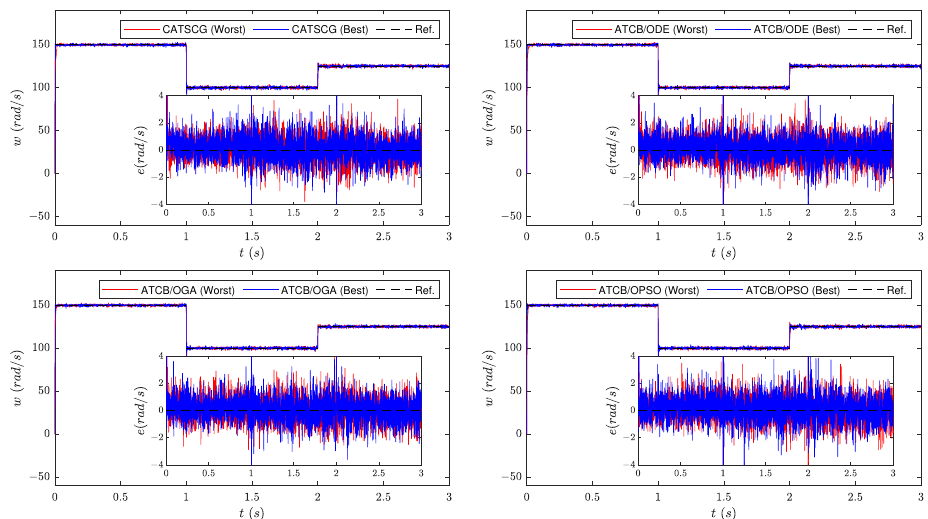
Figure 7. Speed output for the best and worst runs of the adaptive controller tuning, considering